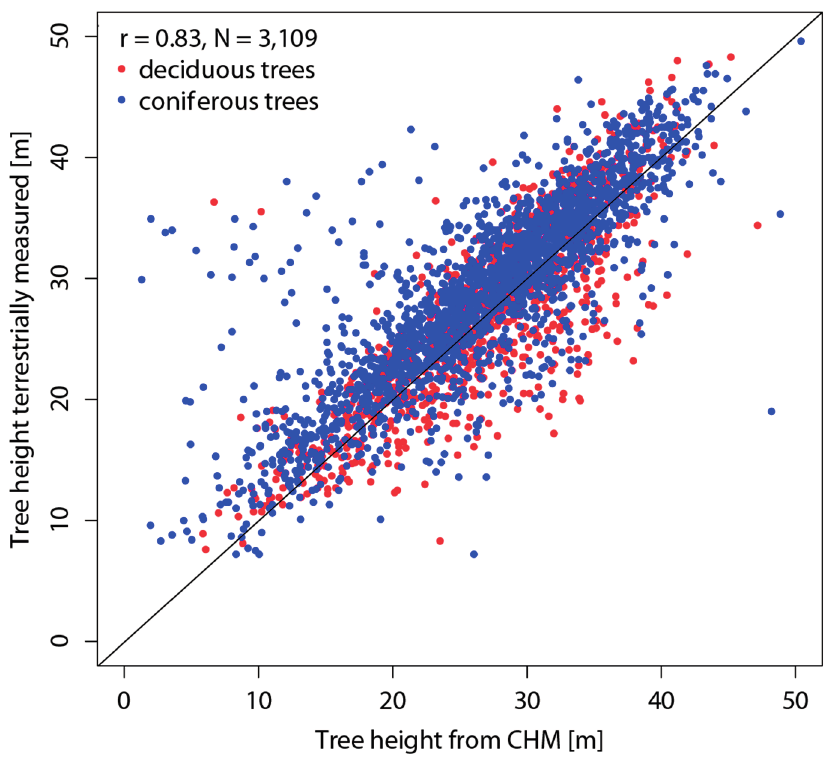
Figure 6. Correlation between tree heights of the CHM and terrestrial tree height measurements. Total number of measurements is 3109. Tree height in the canopy height model refers to the maximum value within a buffer of 2.5 m radius around each individual tree. Tree height in the field was measured using a Vertex ultrasonic